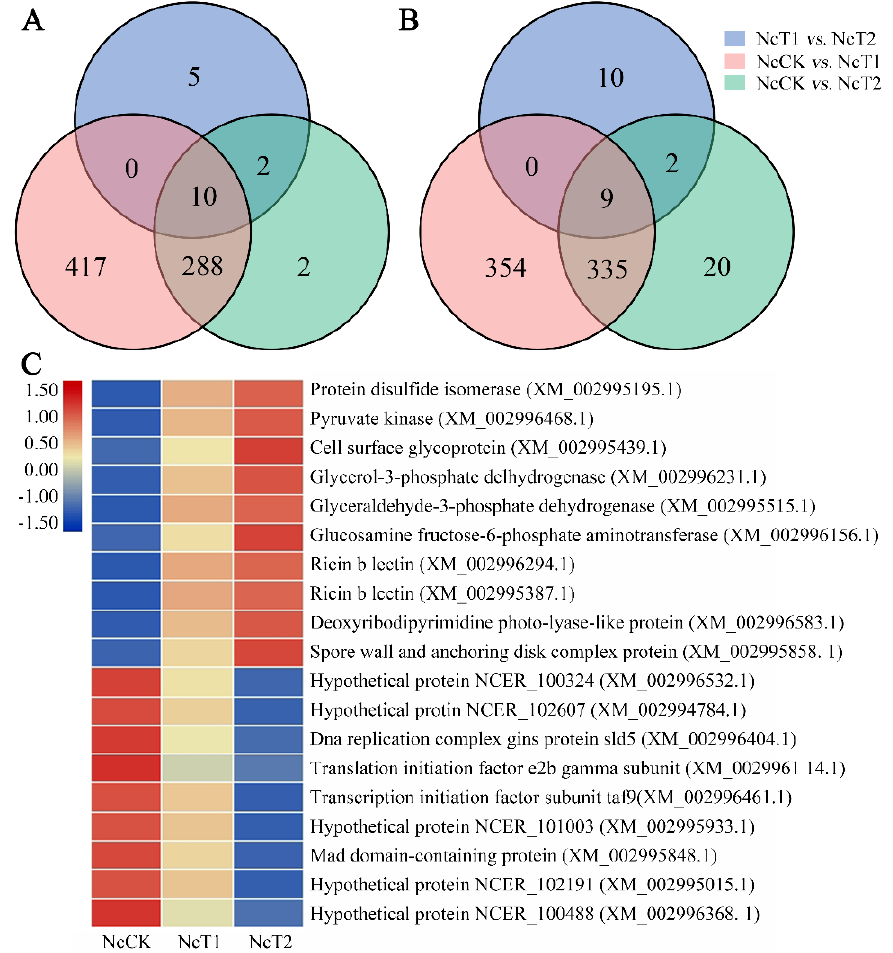
Figure 3. Analysis of DEGs in N. ceranae. ( A ) Venn analysis of upregulated genes in NcCK vs. NcT1, NcCK vs. NcT2, and NcT1 vs. NcT2 comparison groups. ( B ) Venn analysis of downregulated genes in NcCK vs. NcT1, NcCK vs. NcT2, and NcT1 vs. NcT2 comparison groups. ( C ) Heatmap of common DEGs in the NcCK, NcT1, and NcT2 groups.